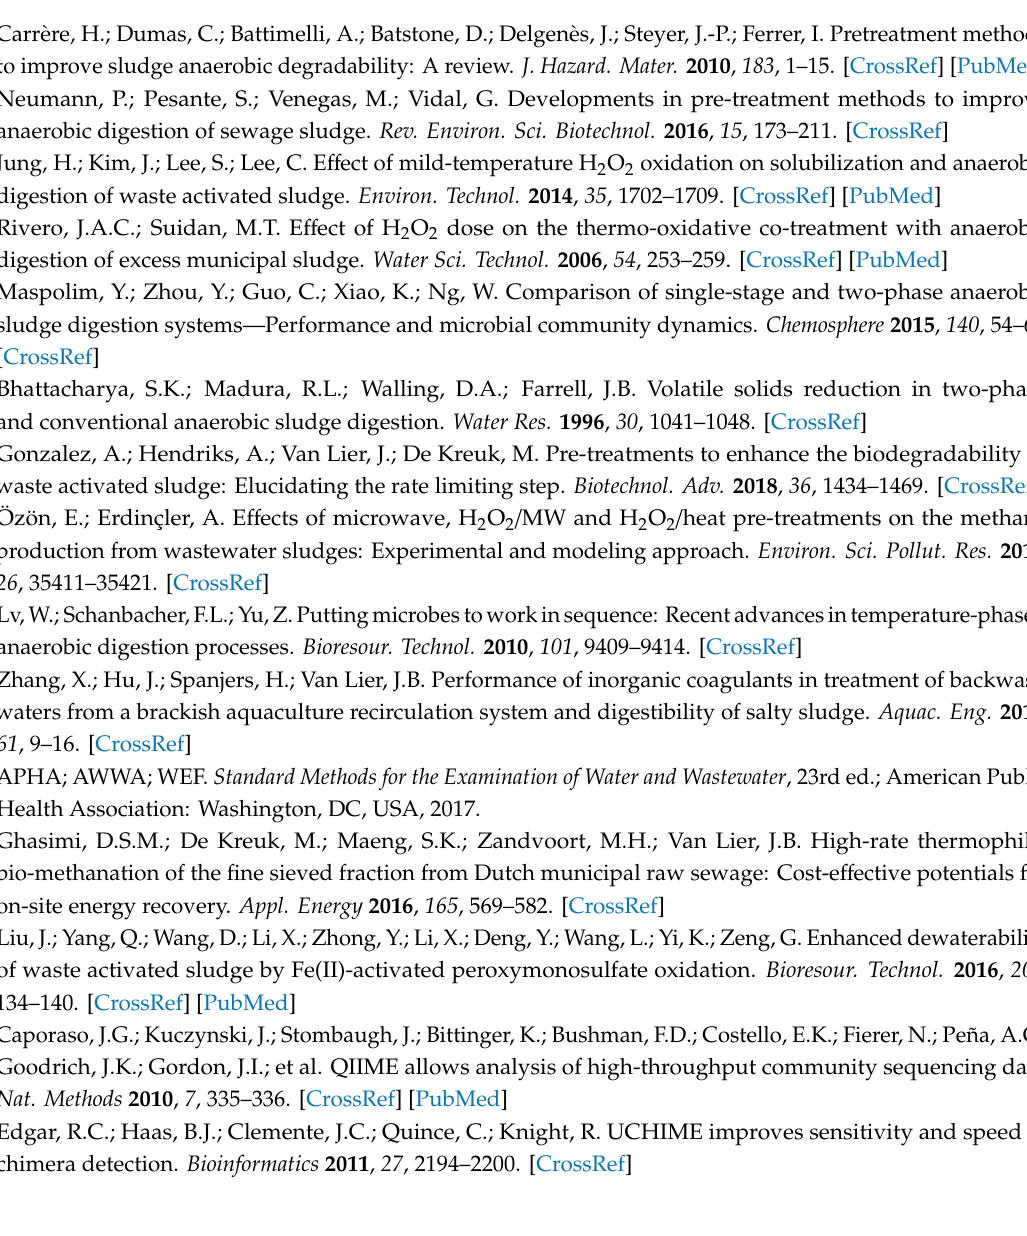
abundances. Table S1: Methane production rates following pre-treatment during Experiment #2, at an application time of 30 min. n = 3 except for reference + 10 mg H 2 O 2 / gTS, which had n = 2; Table S2: Assumptions of the Wilcoxon ranked sign test for biogas production and VS degradation and assumptions for energy